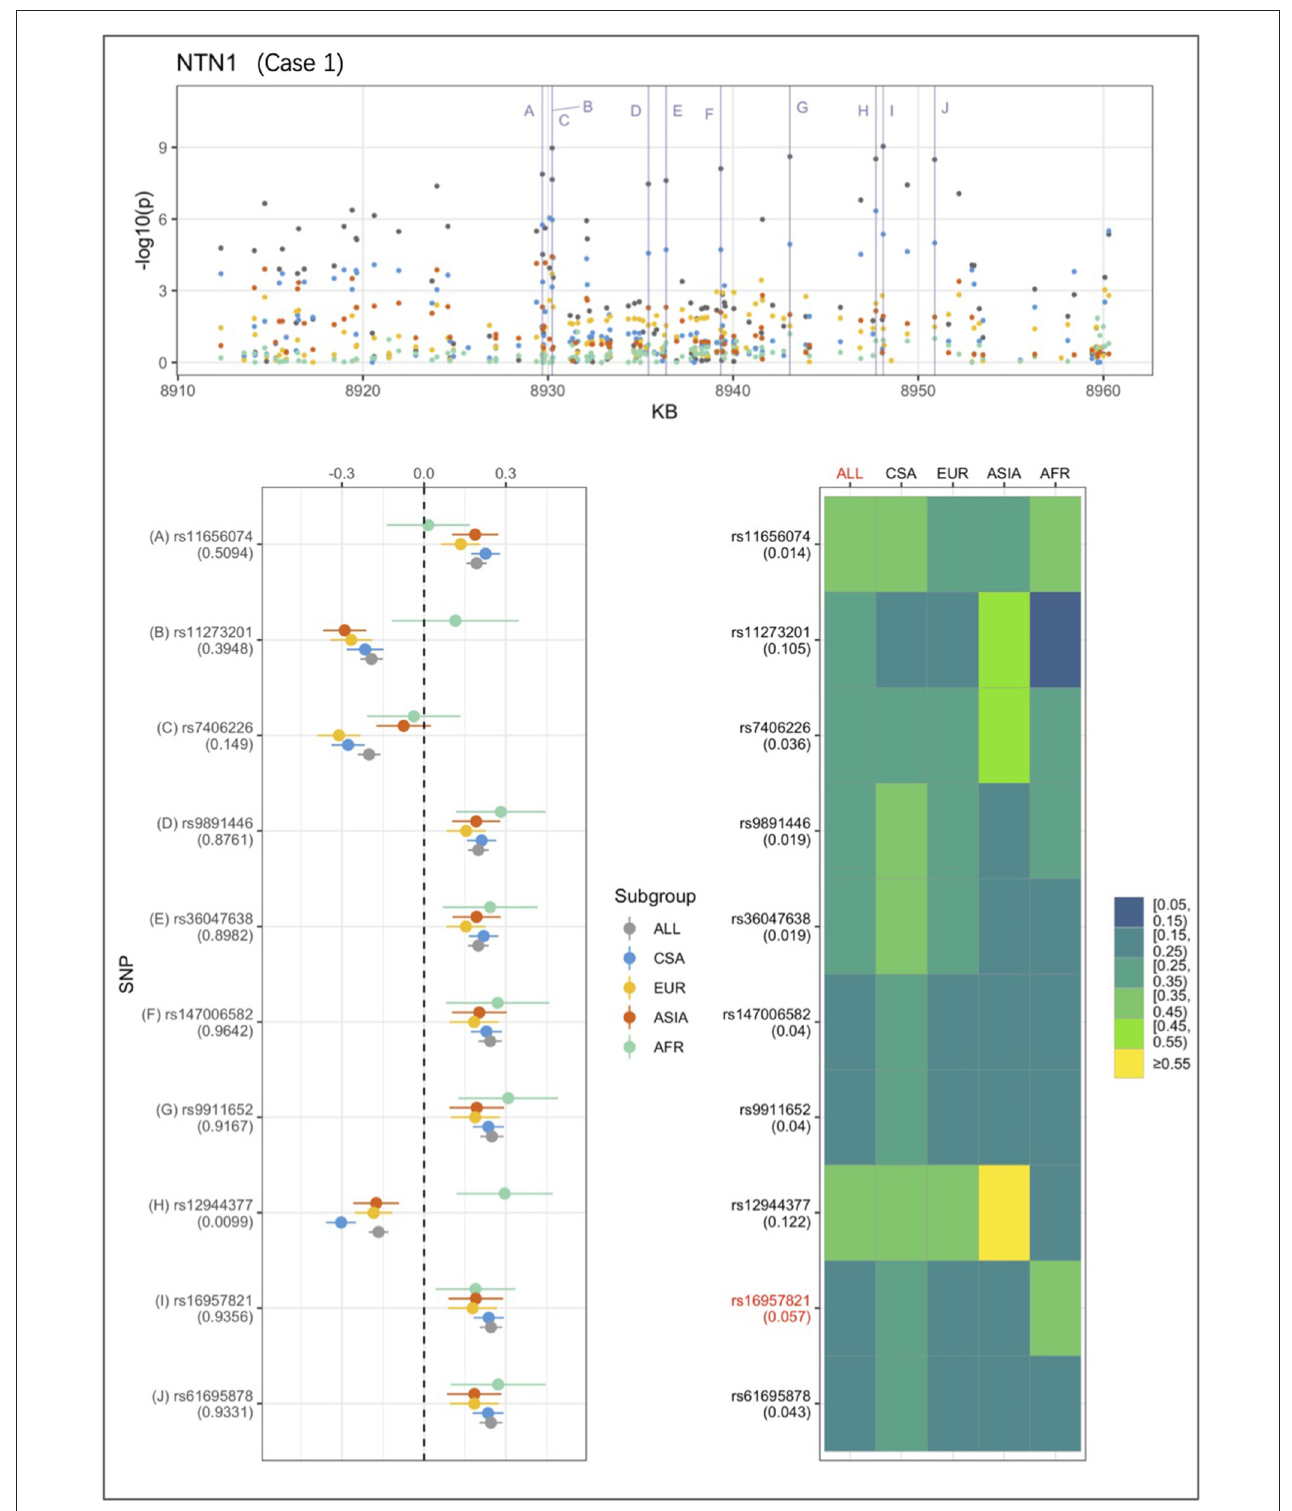
FIGURE 2 | Association peak in 17p13.1 ( NTN1 ) consistent with category 1. SNPs are ordered by base-pair position in lower panels; Q-statistic p -value noted under each SNP in forest plot of effect size; Wright’s F ST value noted under each SNP name in heatmap of effect allele frequencies; lead variant and group with most significant p -value shown in red in